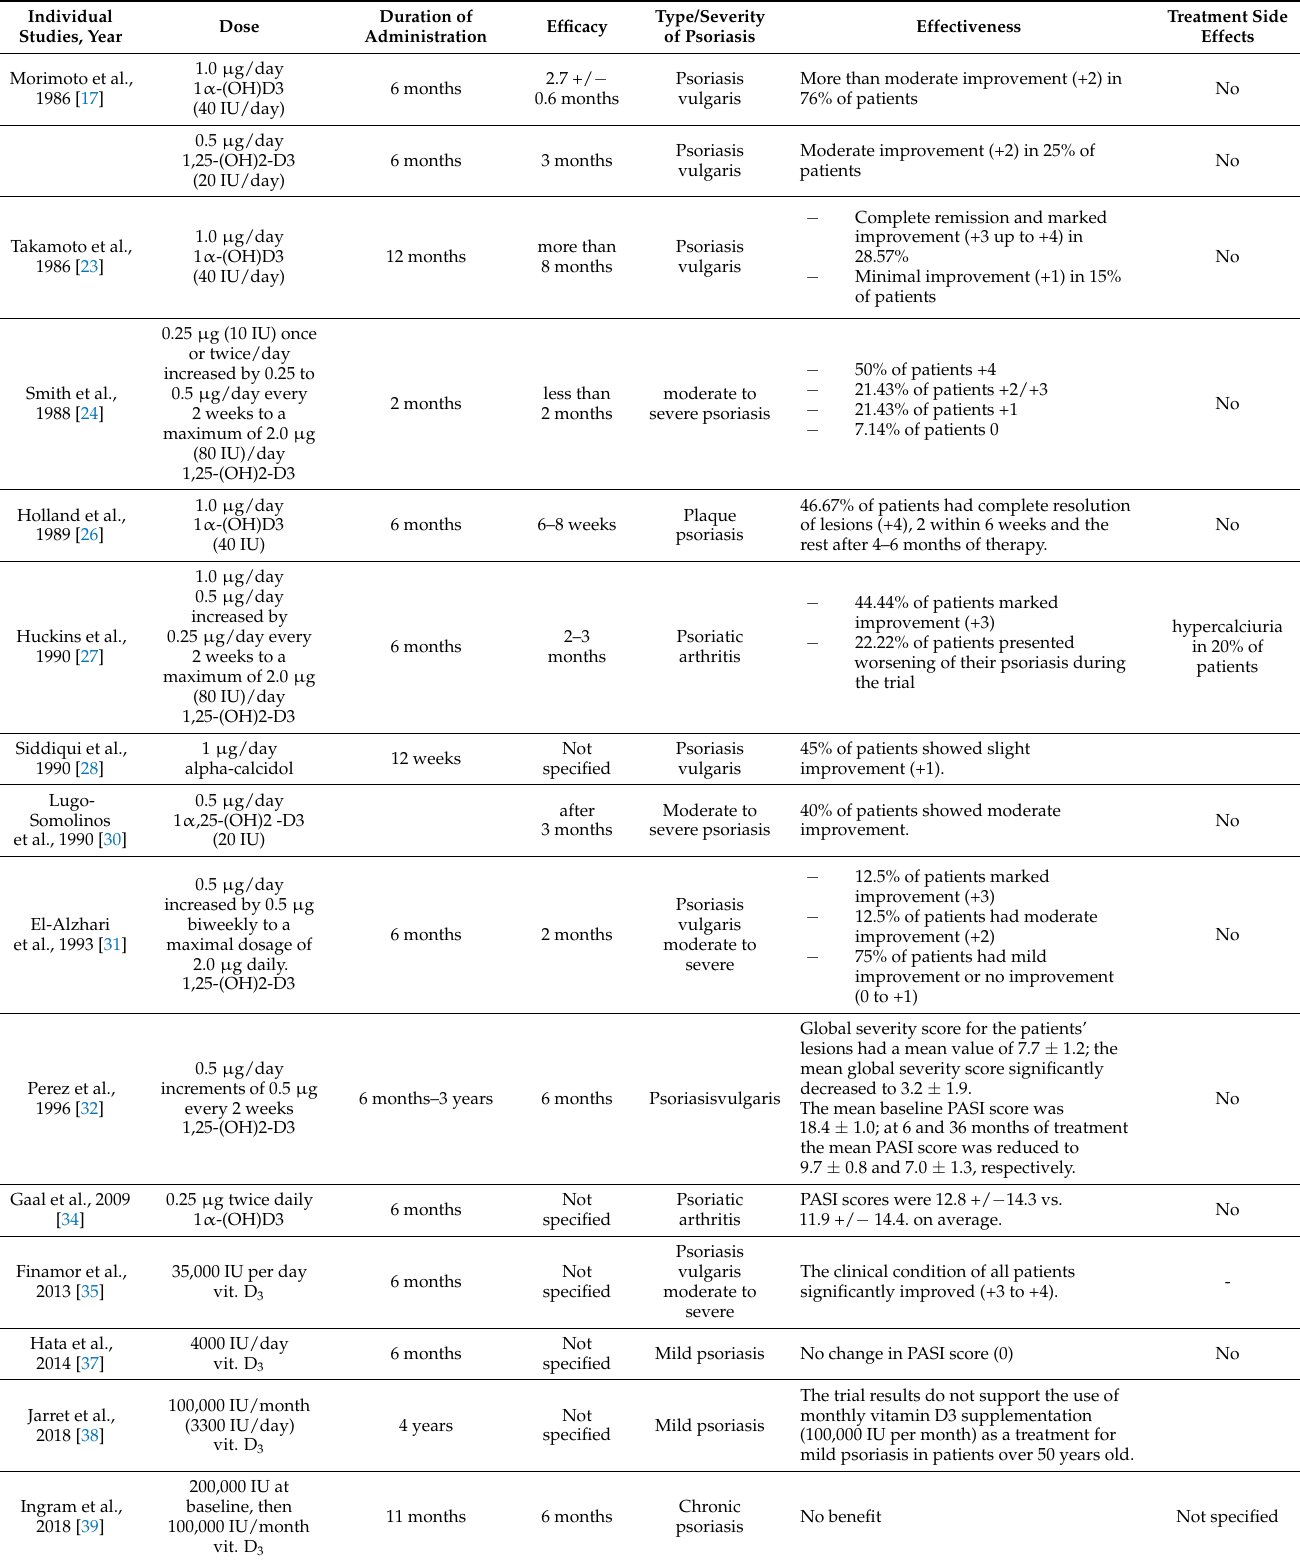
Table 2. Treatment effectiveness after oral administration of vitamin D 3 in patients with